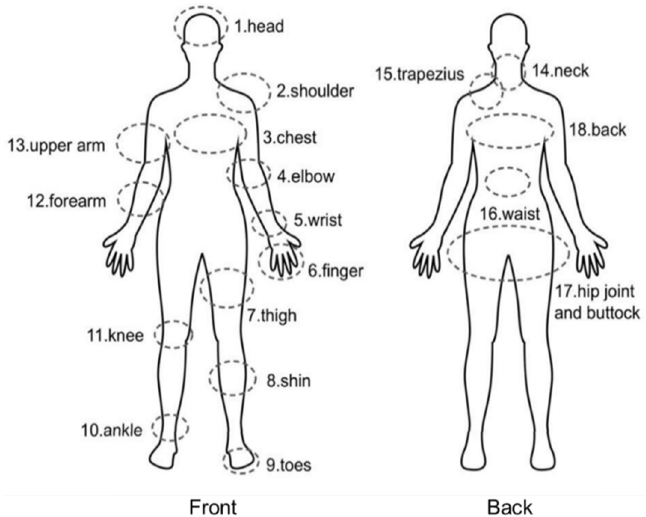
Figure 1. Area of